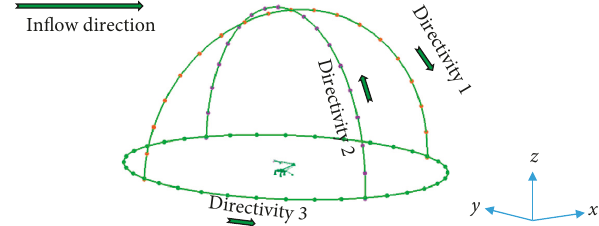
Figure 16: Schematic of the far-field noise-receiving points of